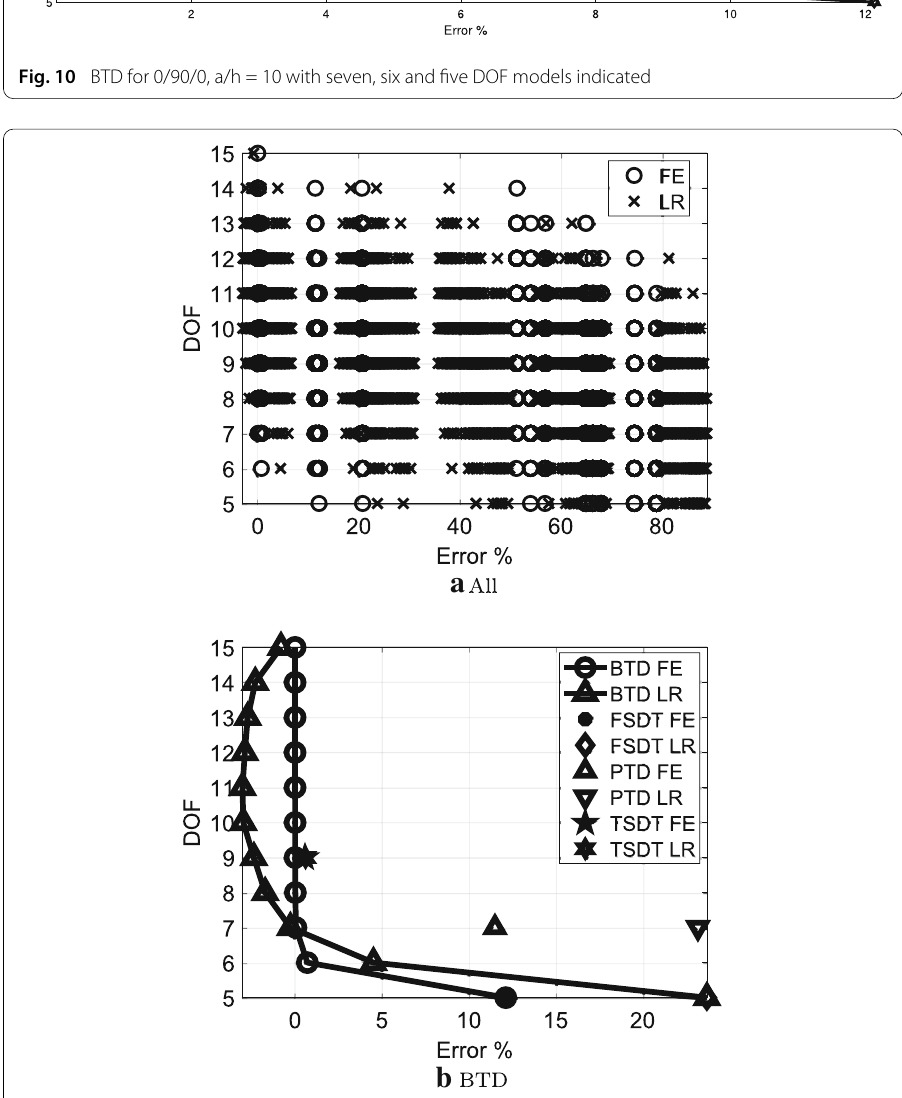
Fig. 11 0/90/0, a/h = 10, comparison between FE and linear regression (LR), 10% training